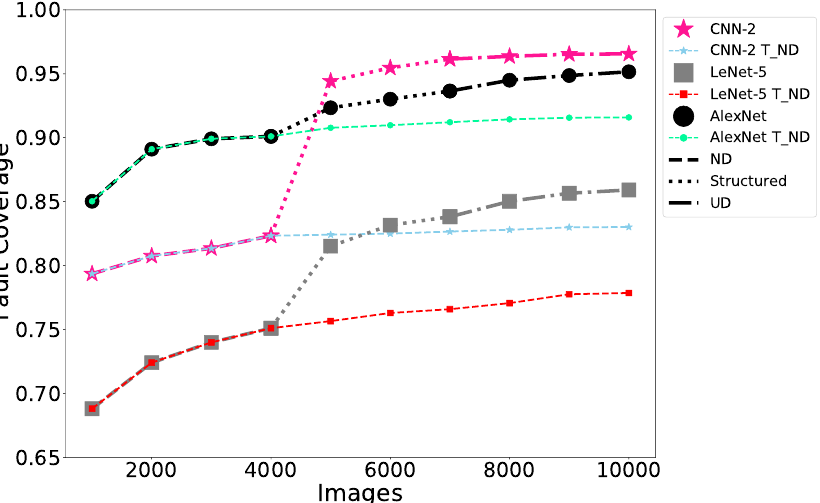
Figure 8. Fault coverage achieved via test sequencing versus the baseline for CNN architectures trained on